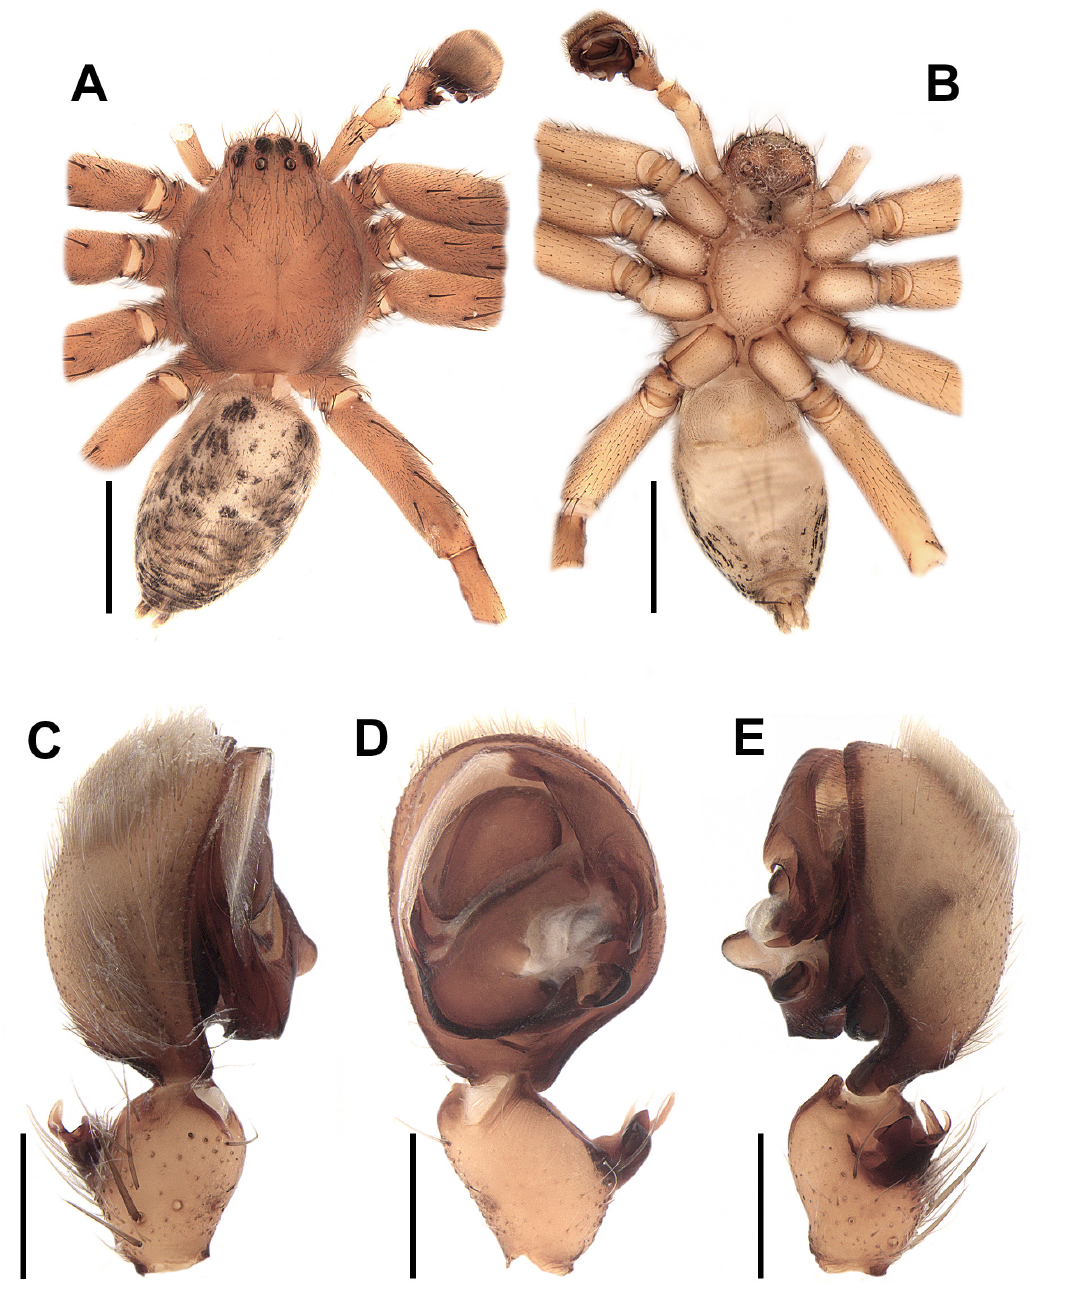
Fig. 3. Cuiambuca aratangi sp. nov., holotype, ♂ (IBSP 167826). A . Habitus, dorsal view. B . Habitus, ventral view. C . Left palp, prolateral view. D . Left palp, ventral view. E . Left palp, retrolateral view. Scale bars: A−B = 2.0 mm; C−E = 0.5